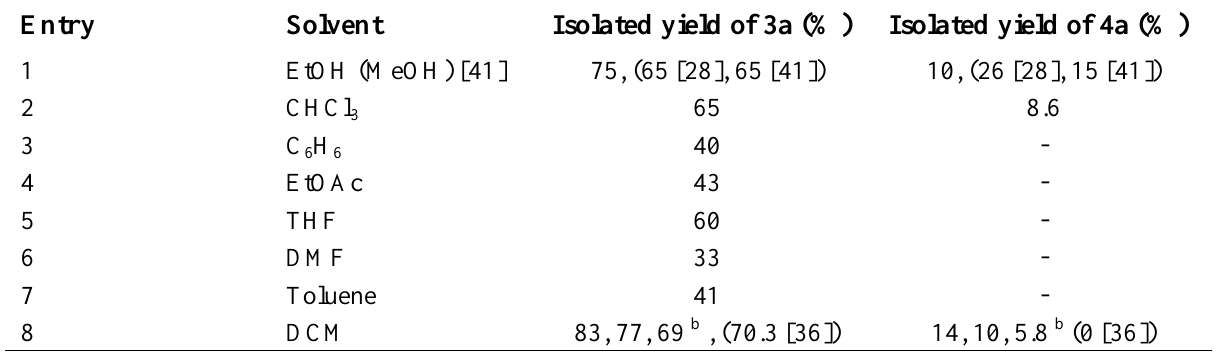
Table 1: Amberlyst™-15 catalyzed condensation of pyrrole and acetone in different solvents a .